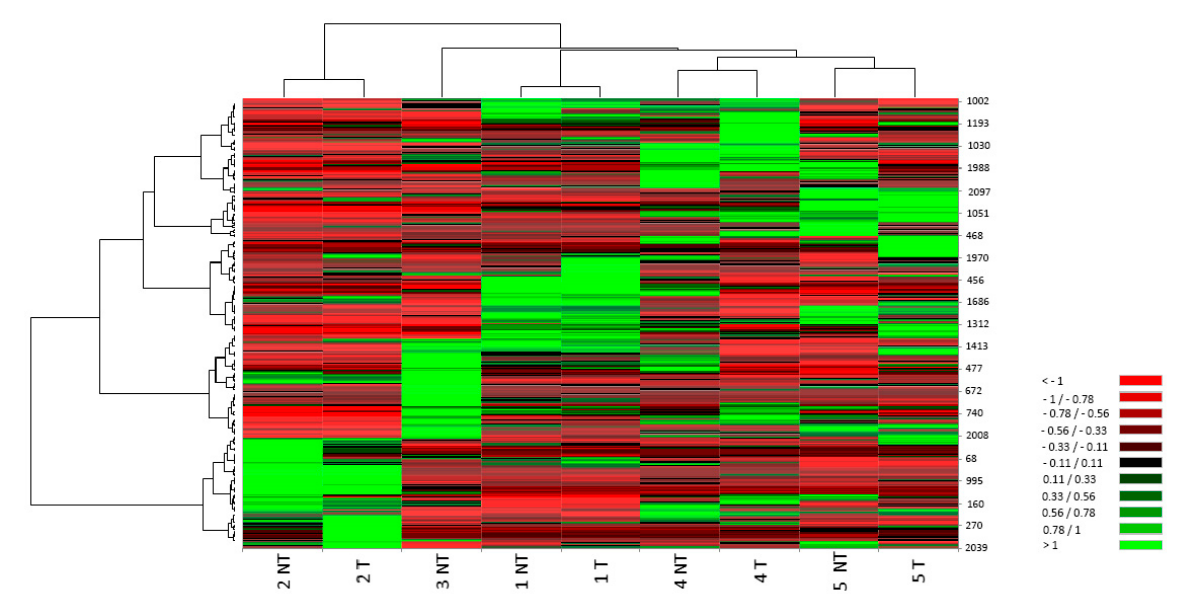
Figure 4. Heat maps: columns correspond to individual preparations of cryopreserved sperm that are untreated (NT) or treated with 20 mg/mL myo-inositol for 20 min after cryopreservation (Post-T), while rows correspond to matched spots. Colour scale (from high value in green to low value in red) illustrates % volume values of the spots.